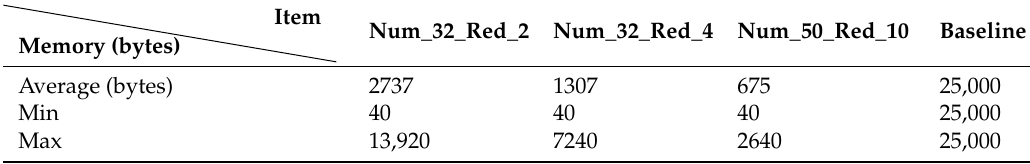
Table 2. Comparison of Memory Efficiency of DTW Combined Sparse Optimization Algorithm.